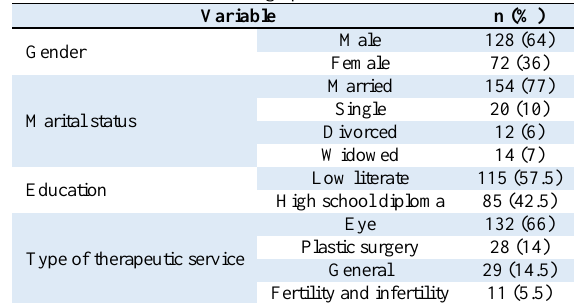
Table 1. Demographic data (n = 200)